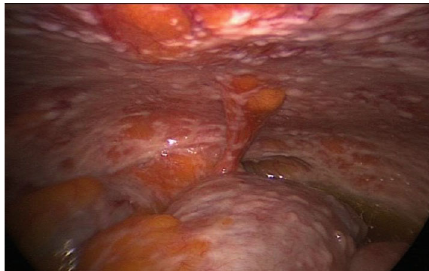
Figure 5: Diagnostic laparoscopy showing multiple peritoneal metastatic